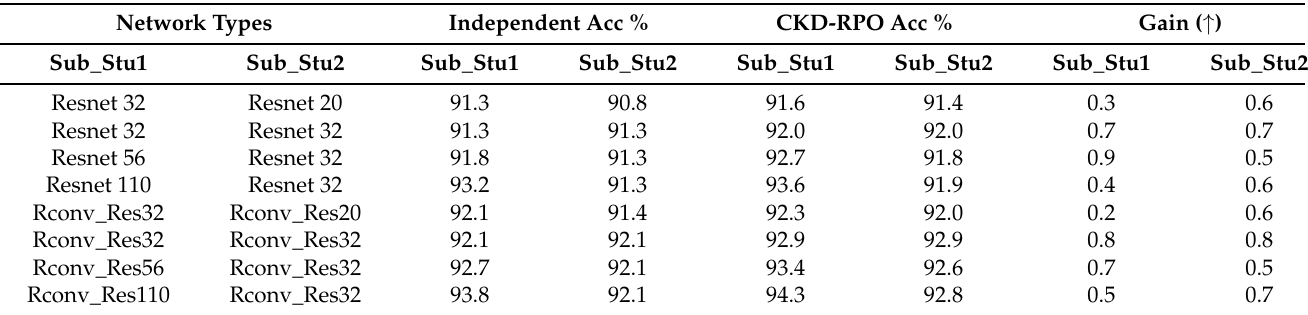
Table 5. Accuracy (%) on the SIRI-WHU dataset. CKD measures the difference in accuracy between the network learned with CKD and the same network learned independently. “Gain” indicates the percentage improvement of the accuracy